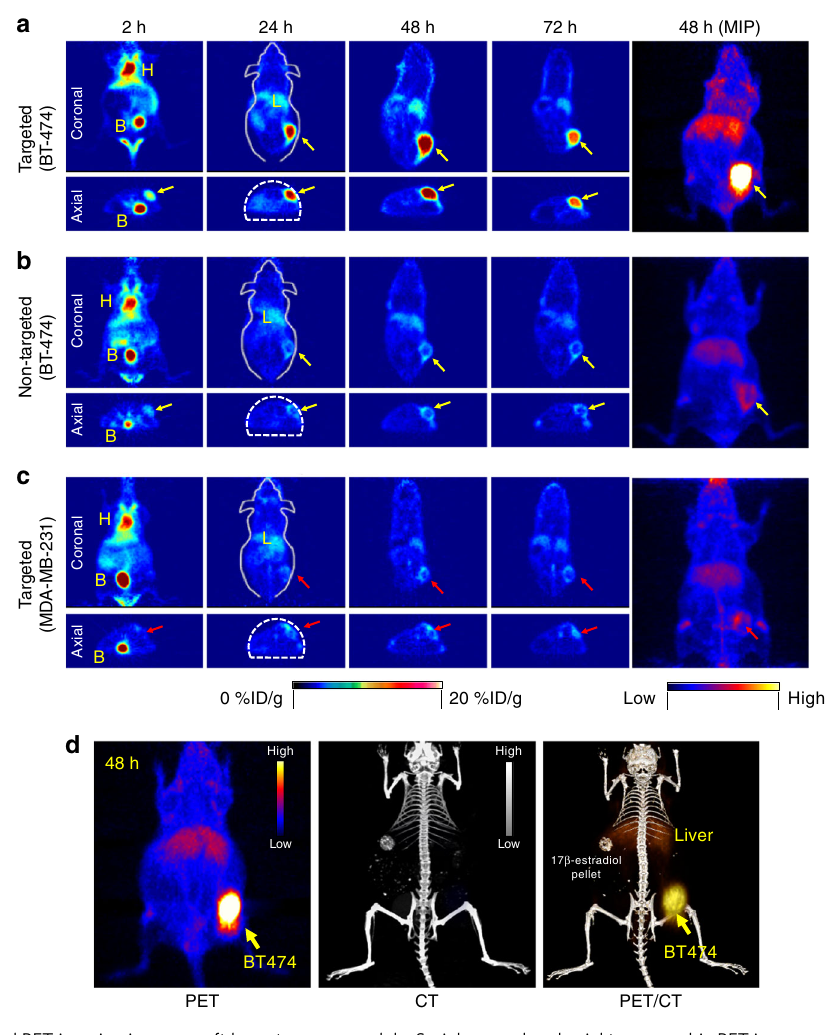
Fig. 3 In vivo HER2-targeted PET imaging in xenograft breast cancer models. Serial coronal and axial tomographic PET images acquired at 2, 24, 48, and 72 h post i.v. injection of radiolabeled particle immunoconjugates in groups of tumor-bearing mice ( N = 5 for each group) as follows — a targeted group: 89 Zr- DFO-scFv-PEG-Cy5-C ’ dots in BT-474 mice, b non-targeted group: 89 Zr-DFO-Ctr/scFv-PEG-Cy5-C ’ dots in BT-474 mice, and c targeted group: 89 Zr-DFO- scFv-PEG-Cy5-C ’ dots in MDA-MB-231 mice. For each group, maximum intensity projection (MIP) images were also acquired at 48 h p.i. H: heart, B: bladder, L: liver. d Representative MIP PET, CT, and PET/CT fusion images of 89 Zr-DFO-scFv-PEG-Cy5-C ’ dots in a BT-474 tumor-bearing mouse. All BT- 474 tumors were marked with yellow arrows, while all MDA-MB-231 tumors were marked with red 89 Zr-DFO-Ctr/scFv-PEG-Cy5-C ’ dots in BT-474 tumors Table 4). Representative PET/CT images of BT-474 tumor- ( n = 5) and 89 Zr-DFO-scFv-PEG-Cy5-C ’ dots in MDA-MB-231 tumors ( n = 5) (Fig. 4h).